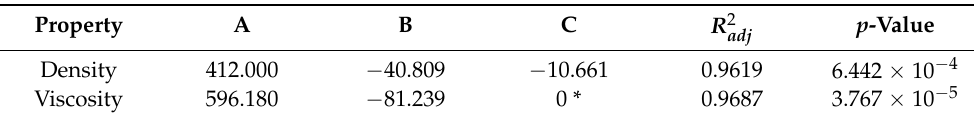
Table 4. Parameters of the regression equation WSD = A + Bx + Cx 2 depicted in Figure 6. Correla- tion coefficients, R 2 , and p-value for both physical properties. adj